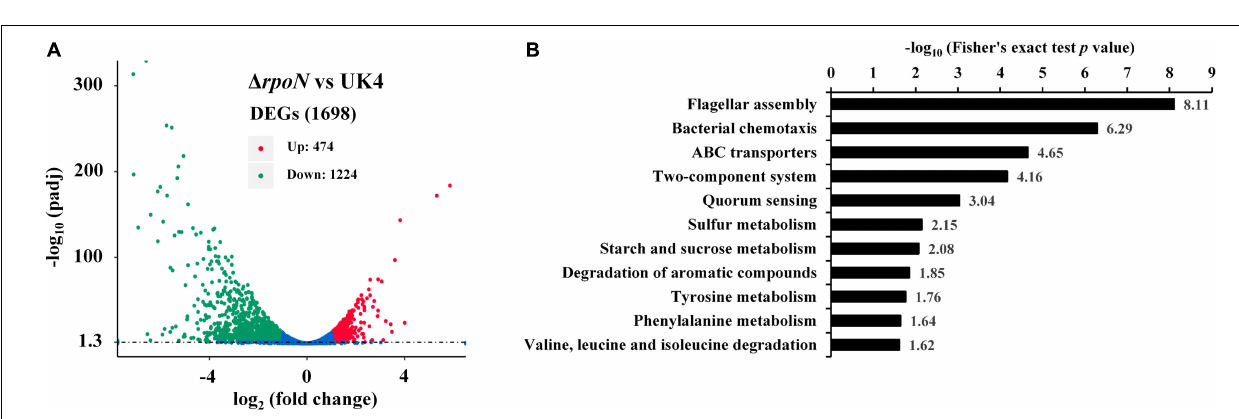
FIGURE 6 | Results from RNA-seq analysis. (A) DEGs between the rpoN mutant and the wild-type strain. The horizontal axis represents fold changes of gene expression, and the vertical axis represents the statistically significant level. The red dots represent significantly upregulated genes, and the green dots represent significantly downregulated genes. (B) Results of KEGG pathway enrichment analysis of downregulated genes in the rpoN mutant. Significantly enriched pathways ( p < 0.05) are shown in the